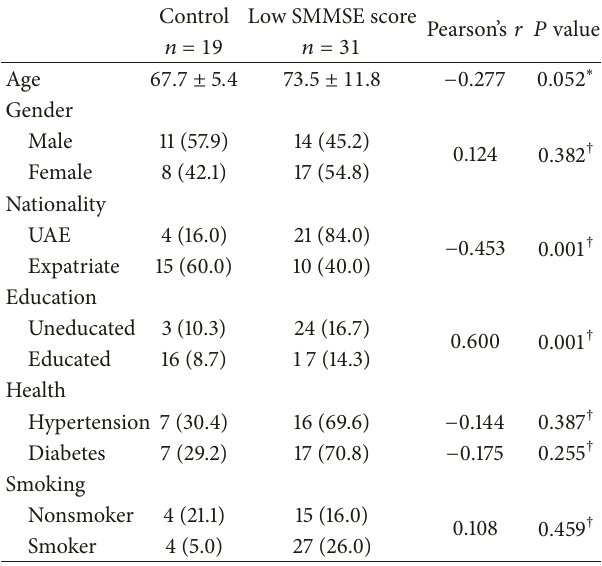
Table 1: Demographic characteristics of the